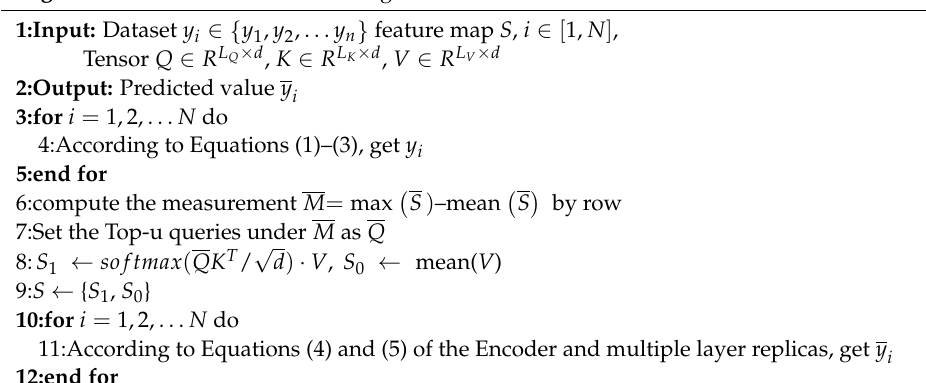
Algorithm 2 The D-P-Transformer